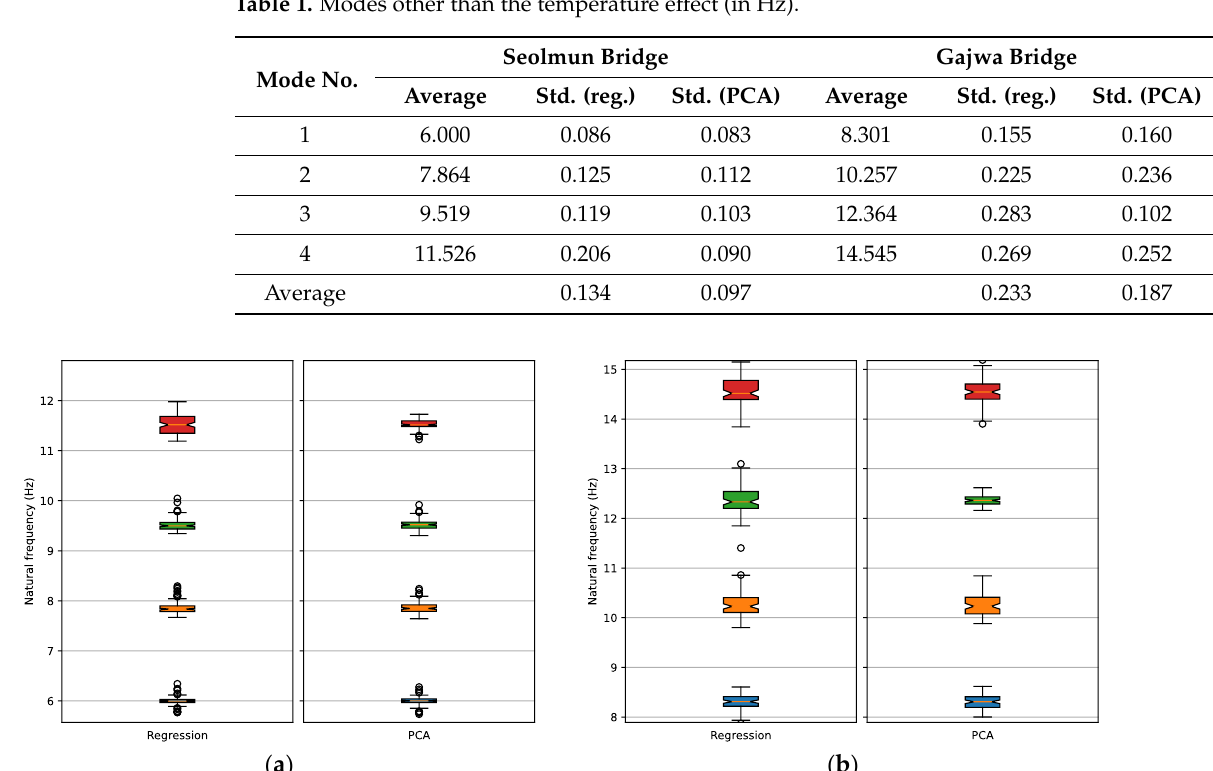
Figure 14. Modes other than the temperature effect: ( a ) Seolmun Bridge; ( b ) Gajwa Bridge.